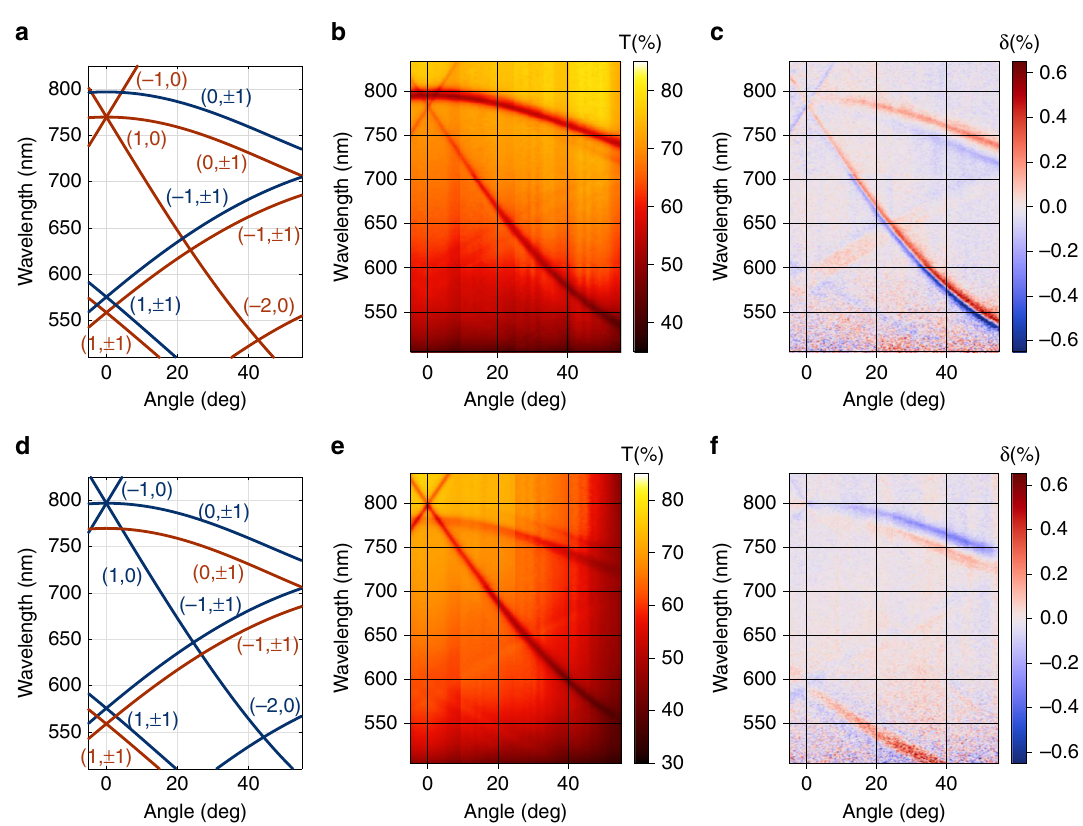
Fig. 3 Wavelength vs. incidence angle spectra of magnetic metasurface for p- (upper panel) and s- (lower panel) polarizations of the incident light. a , d TM- (red color) and TE- (blue color) mode dispersion in magnetic metasurface calculated according to Eqs. (1) and (2). Experimental b , e transmittance and c , f magnetooptical intensity modulation δ spectra of the magnetic